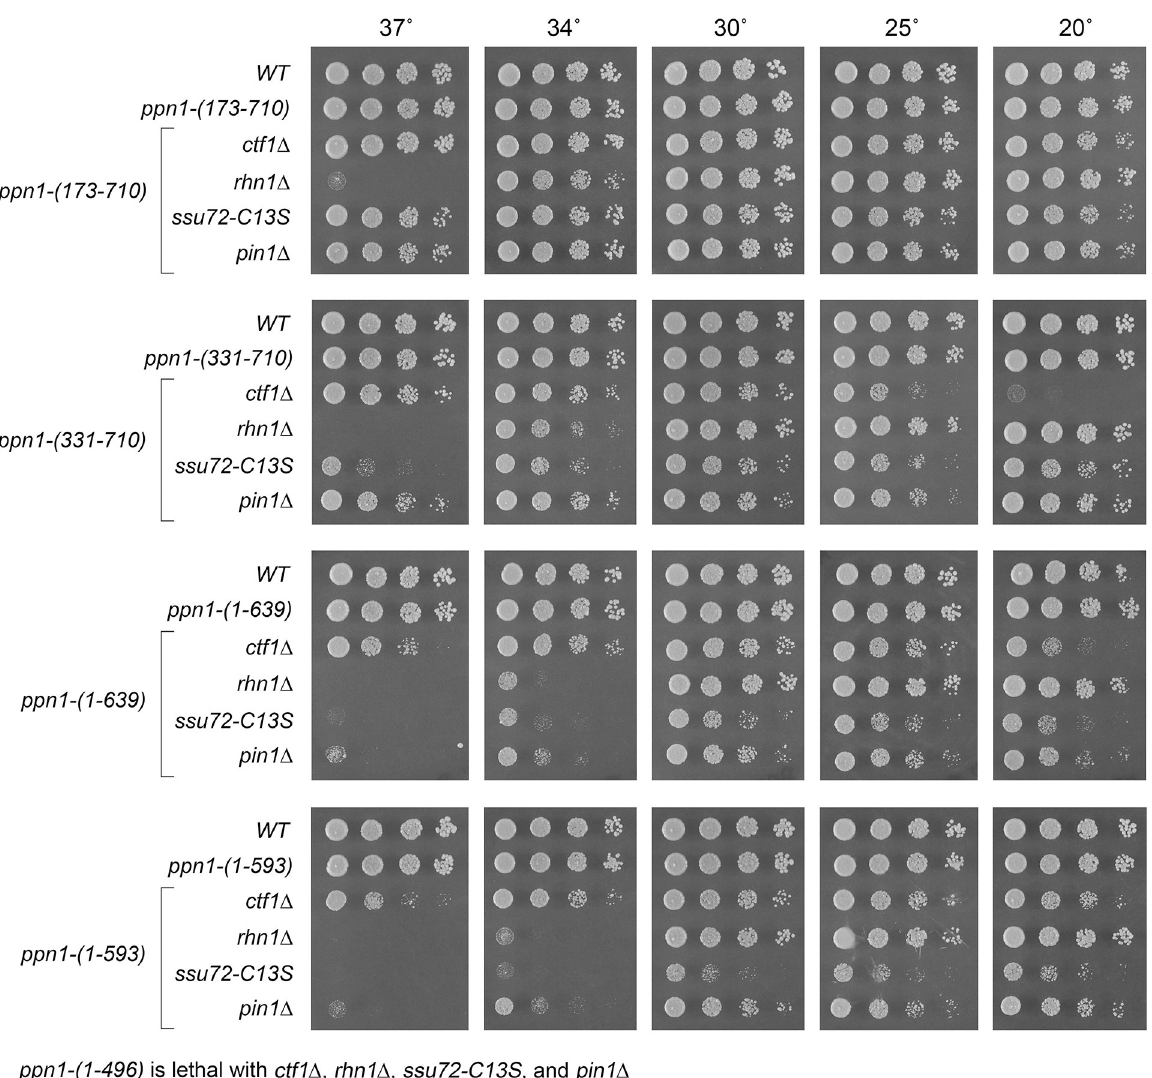
ppn1-(1–639) in all four of the 3’ processing/termination mutant contexts (Fig 9). These results (summarized in S6 Fig) echo those obtained for the CTD mutants, insofar as the N-terminal disordered region of Ppn1 is dispensable in all genetic assays of Ppn1 essentiality, deleting the disordered N-terminus alleviates hypomorphic phenotypes caused by deleting the C-terminal